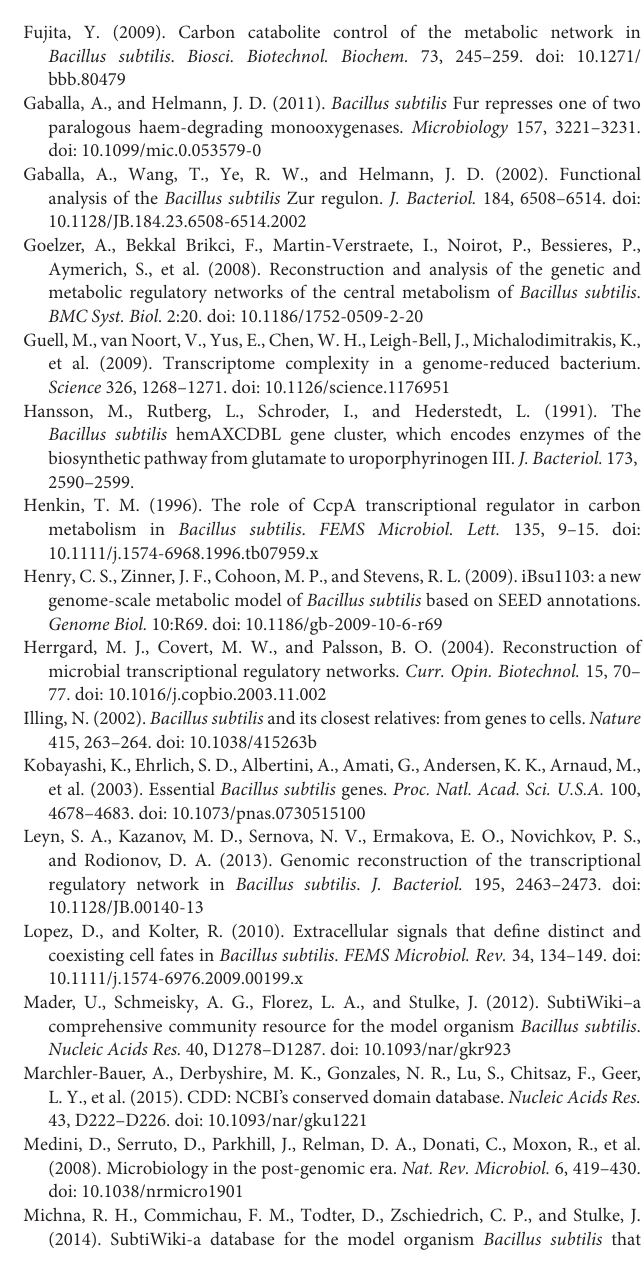
TABLE S1 | Manually curated regulatory network for Bacillus subtilis . TABLE S2 | Regulators described in the regulatory network. TABLE S3 | Atomic Regulons for B. subtilis . TABLE S4 | Curation of Atomic Regulons. TABLE S5 | Atomic Regulons or B. subtilis (version 2). TABLE S6 | Manually curated regulatory network for B. subtilis (version